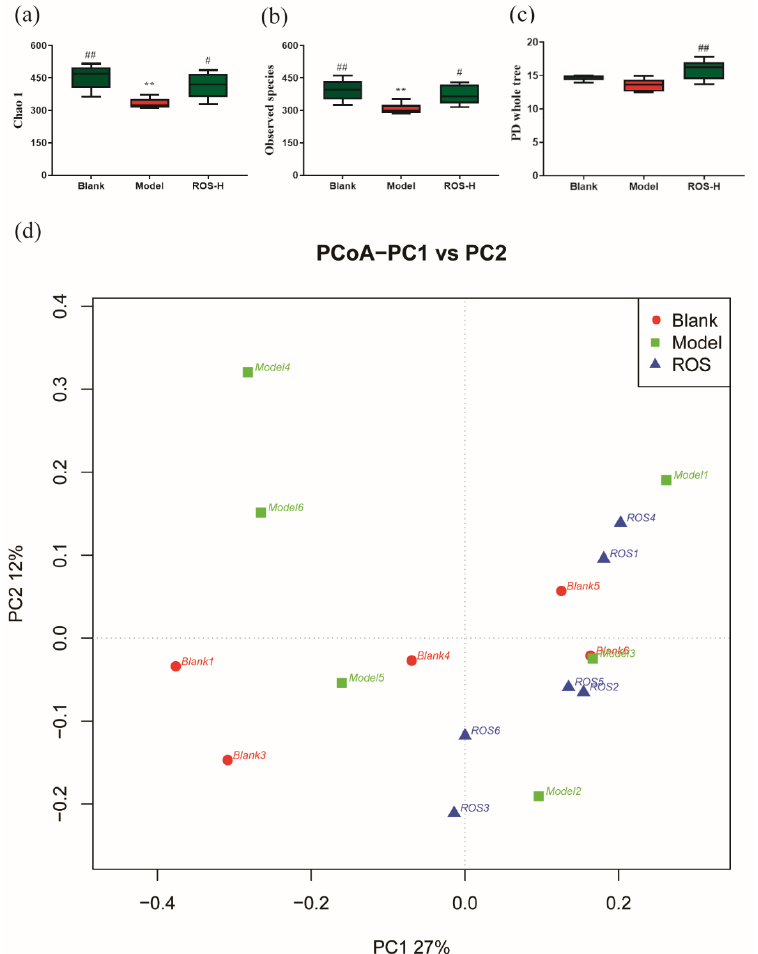
Figure 3. Alpha diversity indices ( a – c ); blank-distilled water treated; model — Loperamide treated; ROS-H: high-dose ROS treated. Beta diversity index ( d ); ROS1-6: high-dose ROS treated. ** p < 0.01 than in the blank group; # p < 0.05 and ## p < 0.01 than in the model group.